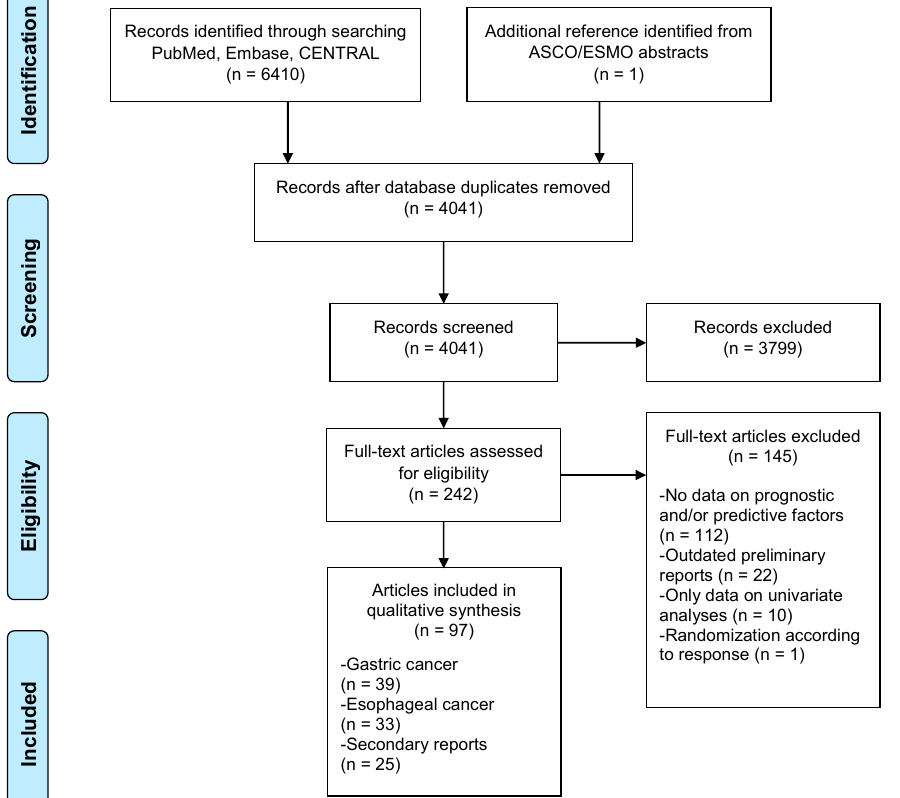
Figure 1. PRISMA flowchart of included studies. ASCO = American Society of Clinical Oncology; CENTRAL = Cochrane Central Register of Controlled Trials; ESMO = European Society for Medical Oncology; PRISMA = Preferred Reporting Items for Systematic Reviews and Meta-Analyses.